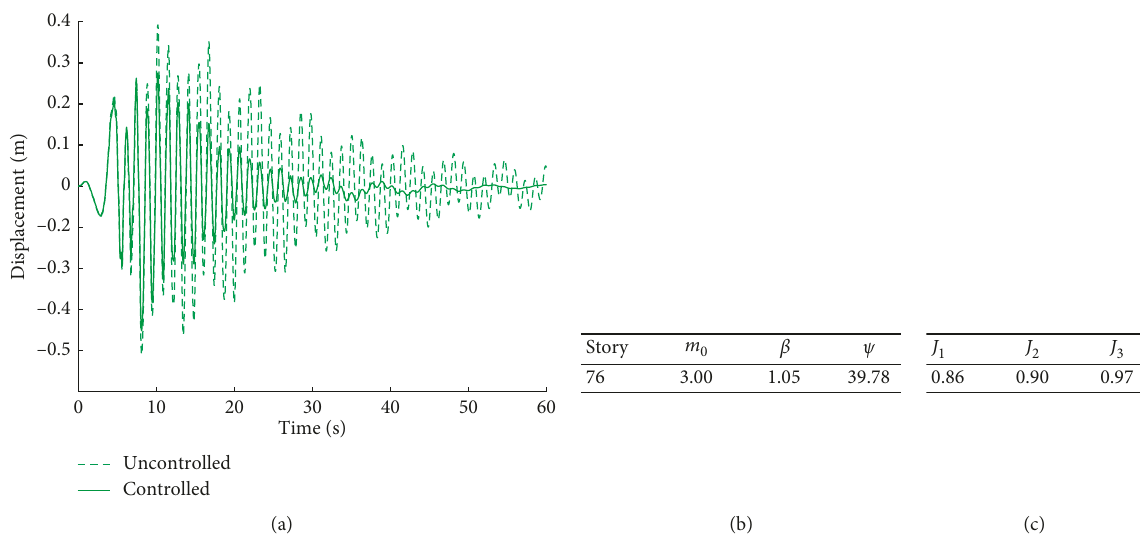
Figure 13: Uncontrolled/controlled responses under the Kobe earthquake. (a) Roof displacement response. (b) TMD specifications. (c) Objective